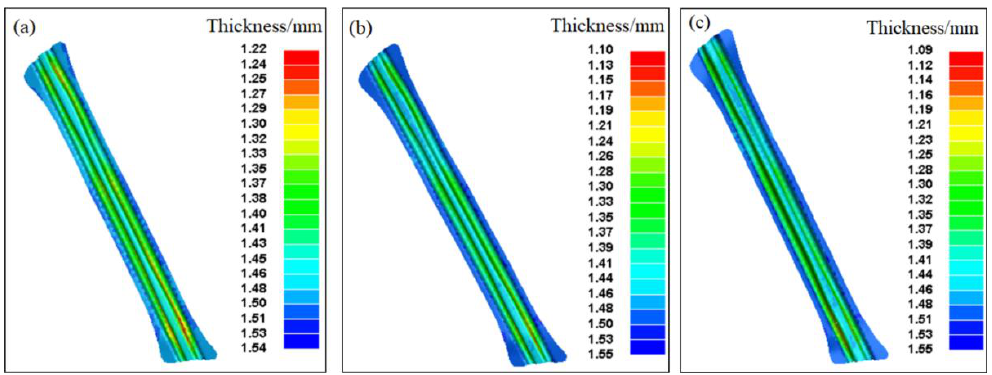
Figure 6. Thickness distribution of formed parts at end of hot stamping, ( a ) process 1, ( b ) process 2 and ( c ) process 3.